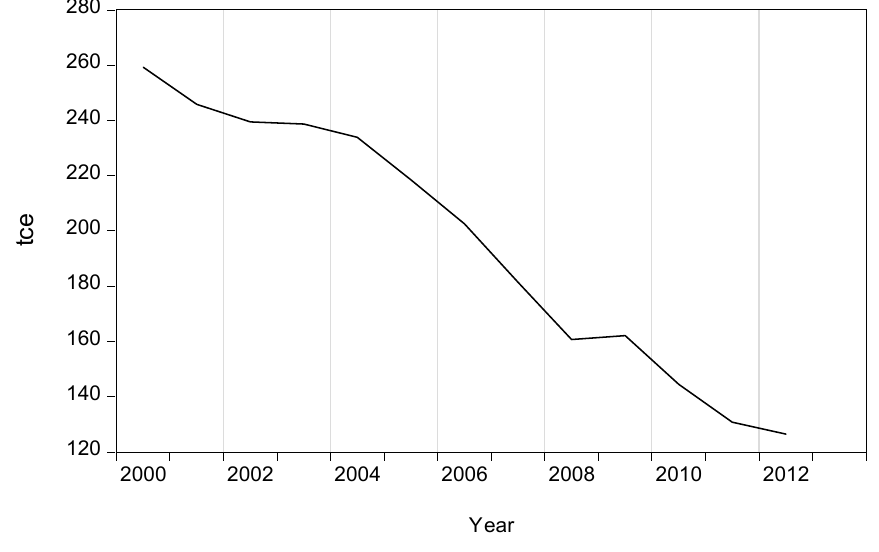
Figure 2. Energy consumption per million RMB of industrial value added, China.